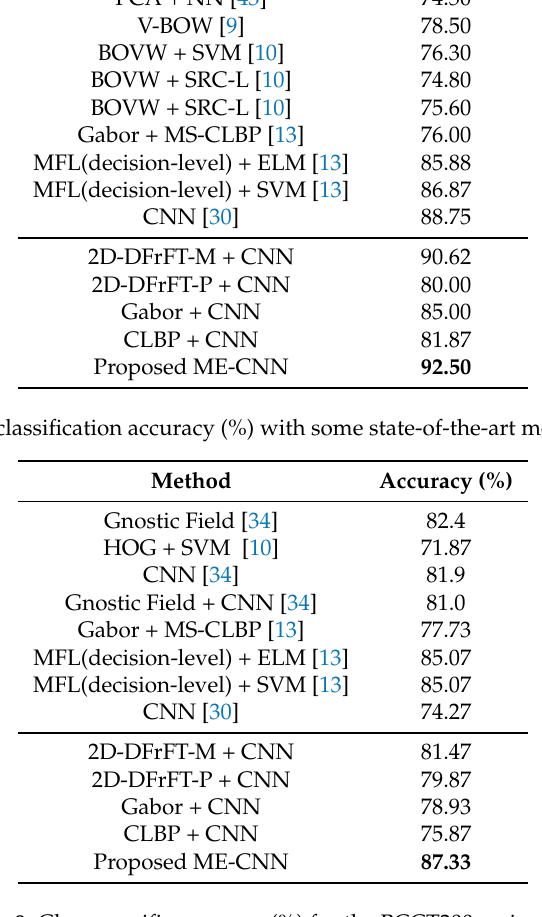
Table 8. Class-specific accuracy (%) for the BCCT200-resize data.